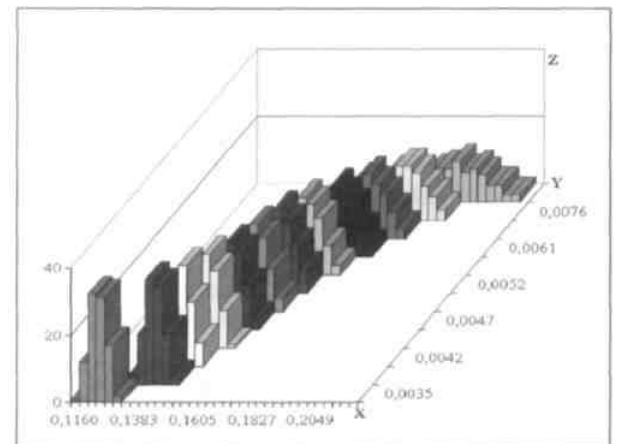
Fig 3. Portfolio anatomy for adequate